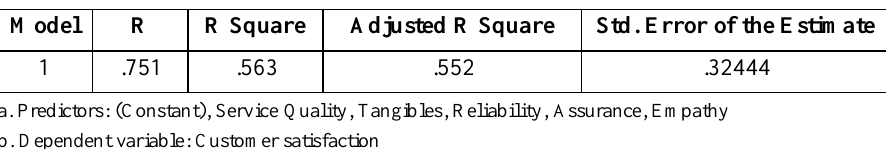
Table 5: Model Summary